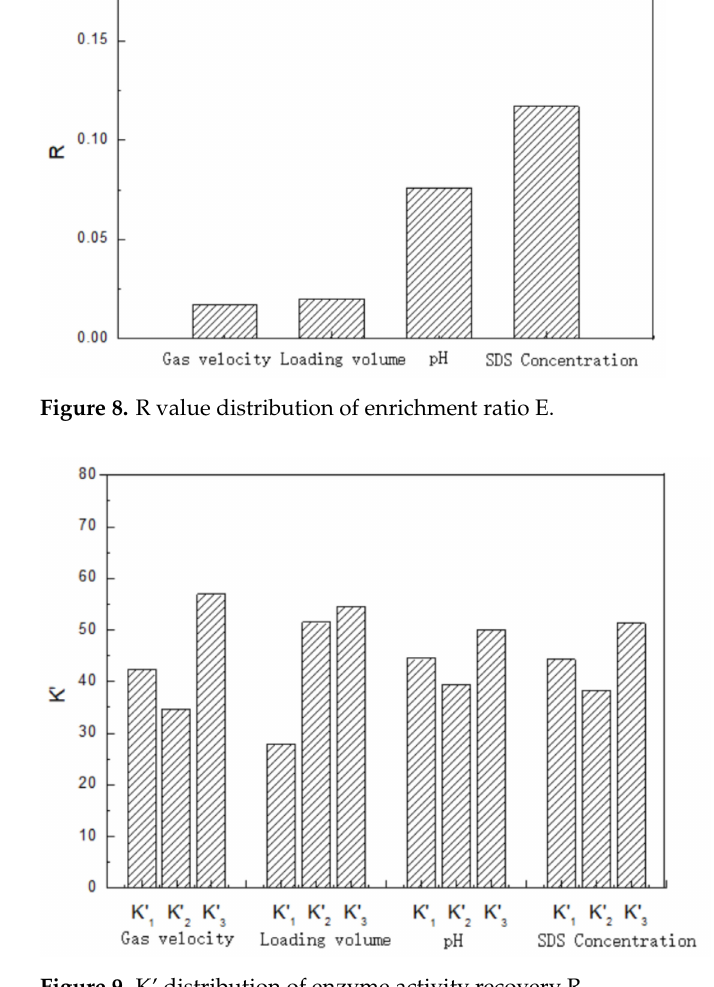
Figure 9. K’ distribution of enzyme activity recovery